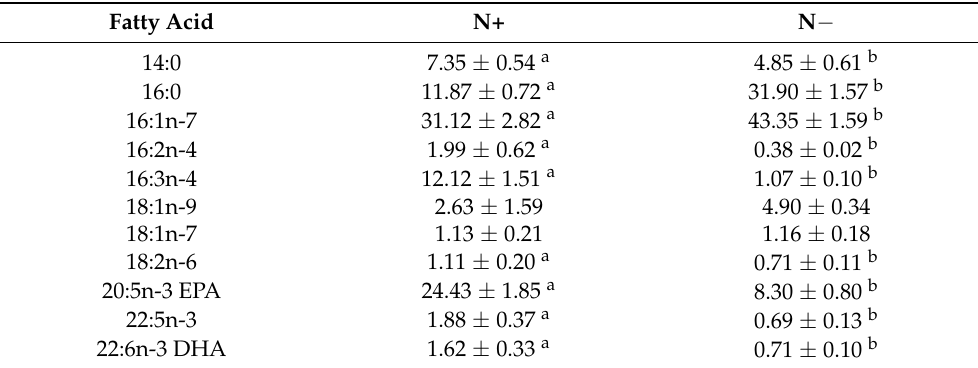
Table 2. Fatty acids composition (%, w/w ) of P. tricornutum cultivated for 15 days under standard (N+) and starvation condition (N − ).